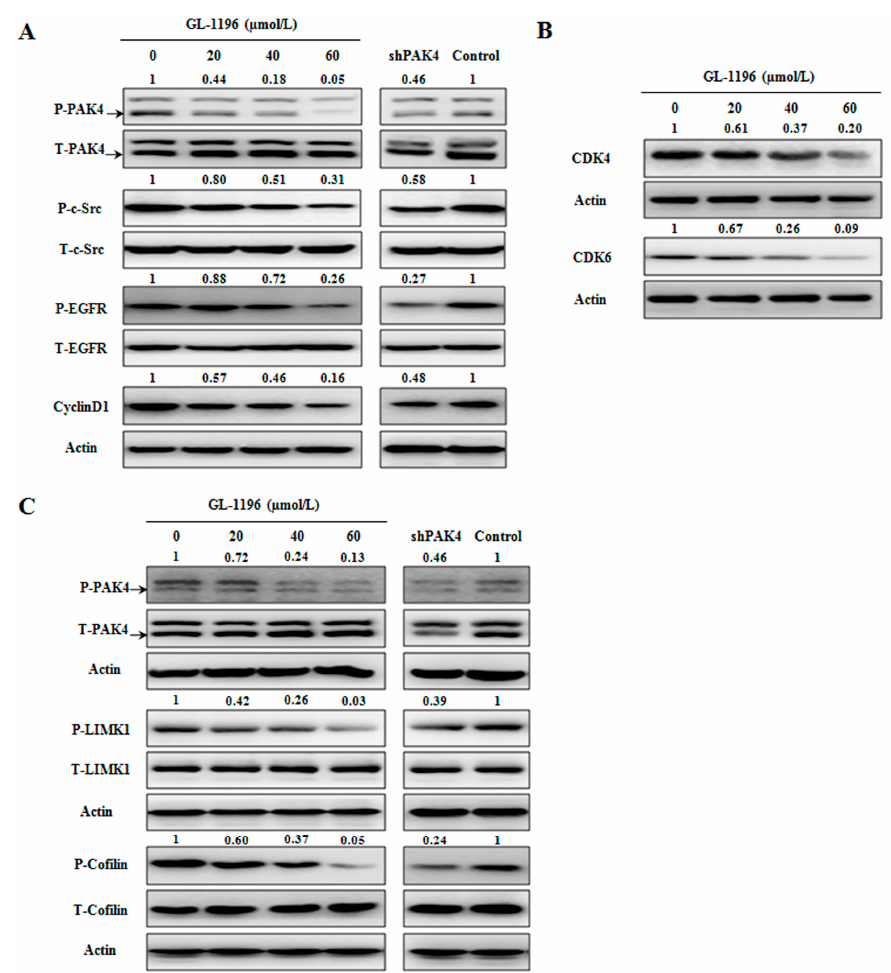
Figure 8. The effect of GL-1196 on PAK4-mediated signaling pathways involving proliferation and invasion. ( A ) GL-1196 inhibits PAK4/c-Src/EGFR/cyclinD1 pathway; ( B ) GL-1196 down-regulated the expression of CDK4/6; ( C ) GL-1196 inhibits PAK4/LIMK1/cofilin pathway.